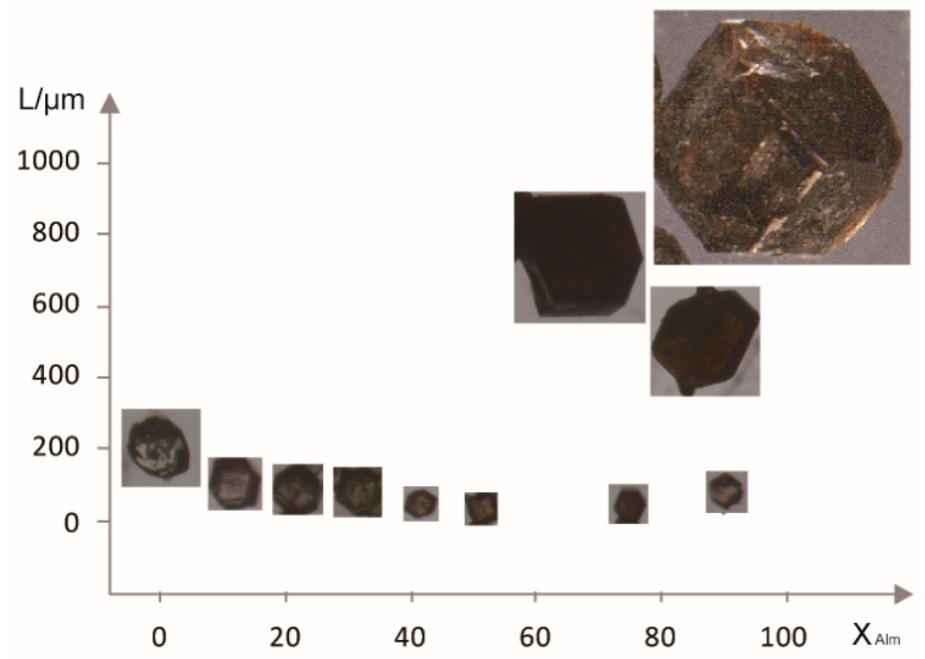
Figure 2. Typical microphotographs and dimensions of Alm-Pyr crystals synthesized in this study with increasing Alm contents.